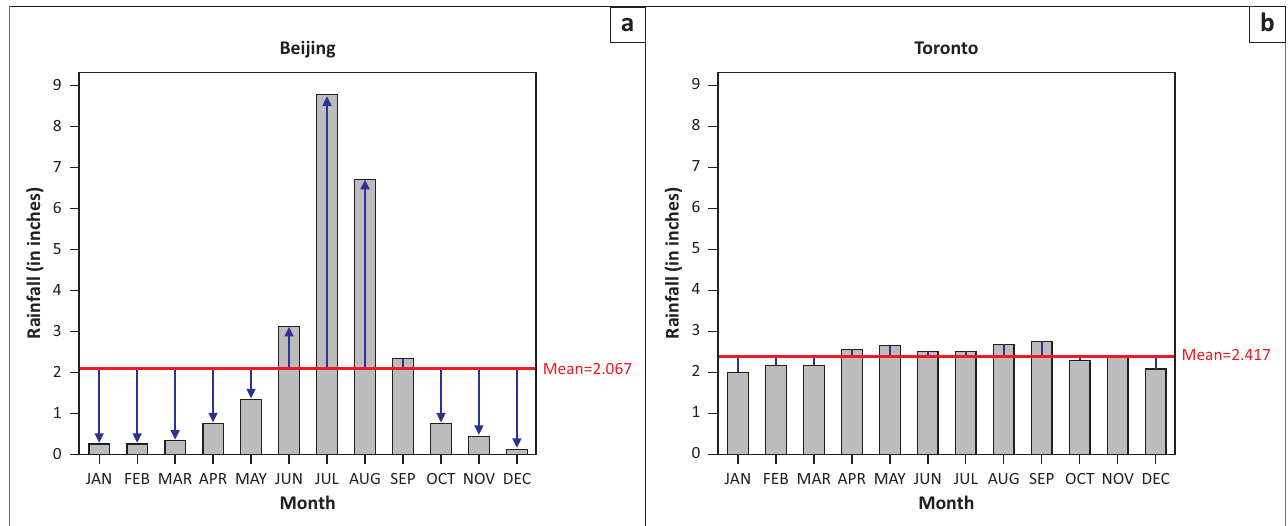
FIGURE 3: Rainfall for Beijing and Toronto